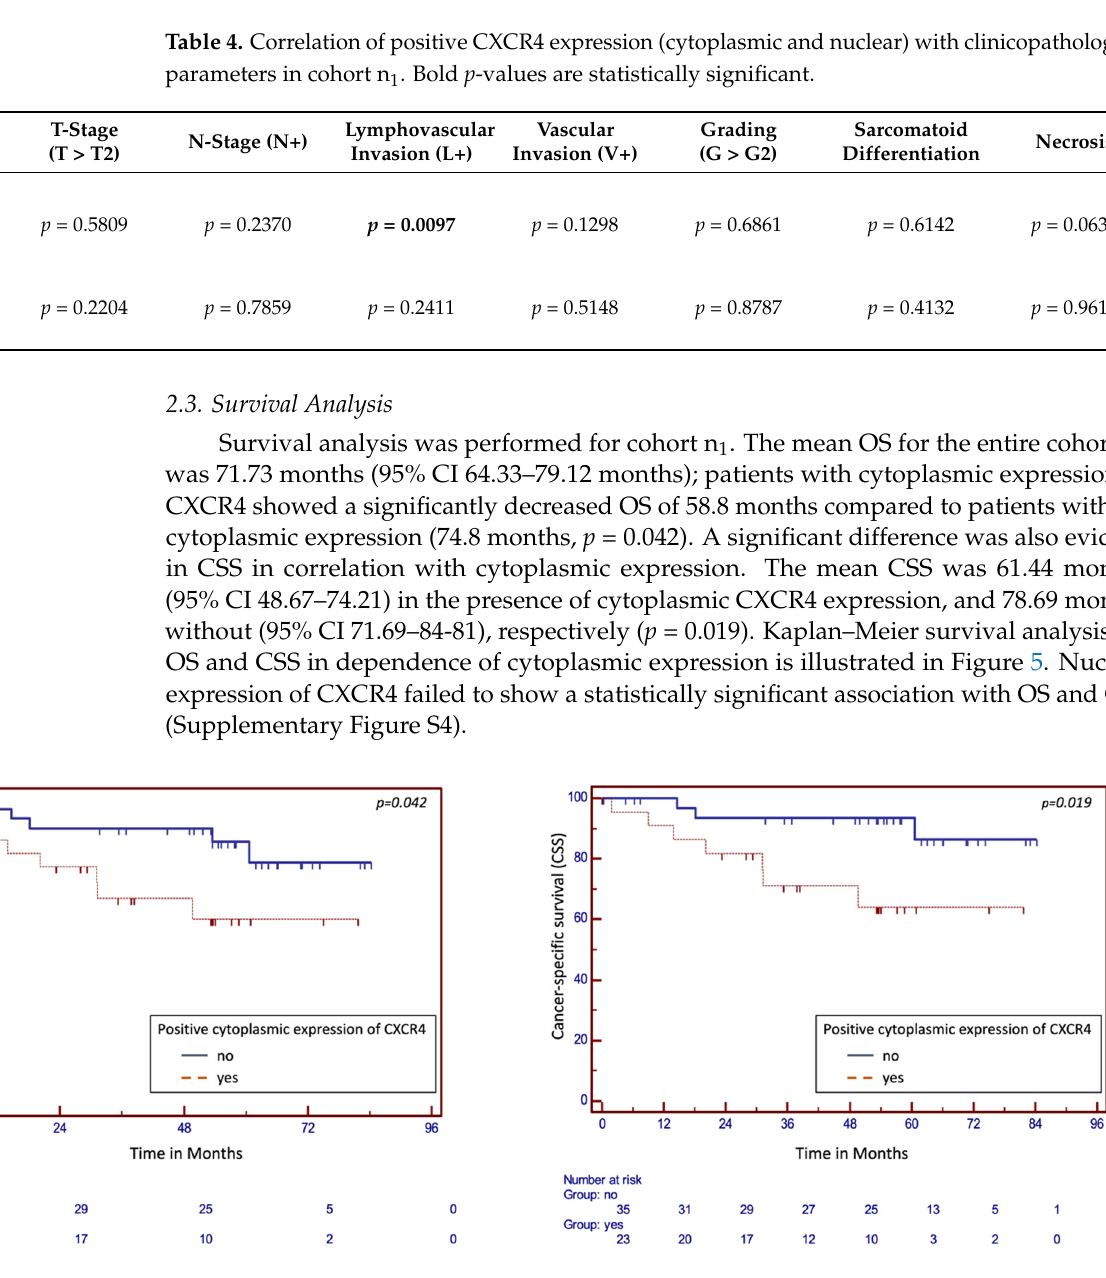
Table 5. Univariate and multivariate Cox regression analysis for cancer-specific survival (CSS) and overall survival (OS). Bold p -values are statistically significant.